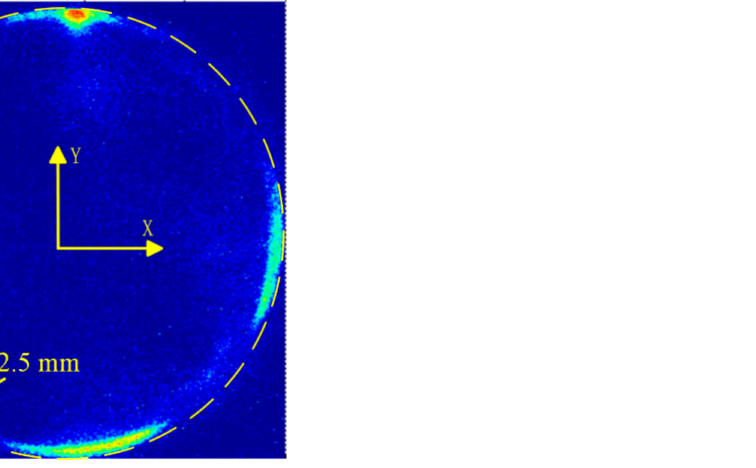
diameters. The impedance of the transducer was about 95 Ω during cavitation processing. 170, and 190 V, respectively.